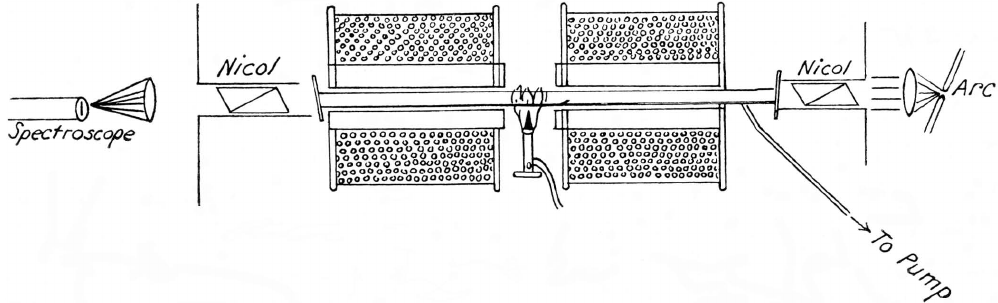
Figure 3. A schematic diagram of an experiment in physics employing Nicol prisms of Iceland spar. In this case, the Faraday e ff ect in hot sodium vapor is being investigated (Wood, 1905). The direction of polarization of a light beam coming from the right is rotated within the vapor by the magnetic field produced by two coils.